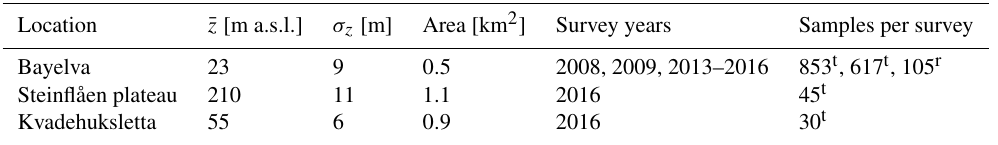
Table 1. Overview of the study sites and snow surveys. z is the mean elevation, and σ z is the standard deviation in the elevation, both based on the NPI (2014) DEM. t : transect; r ; randomized array.